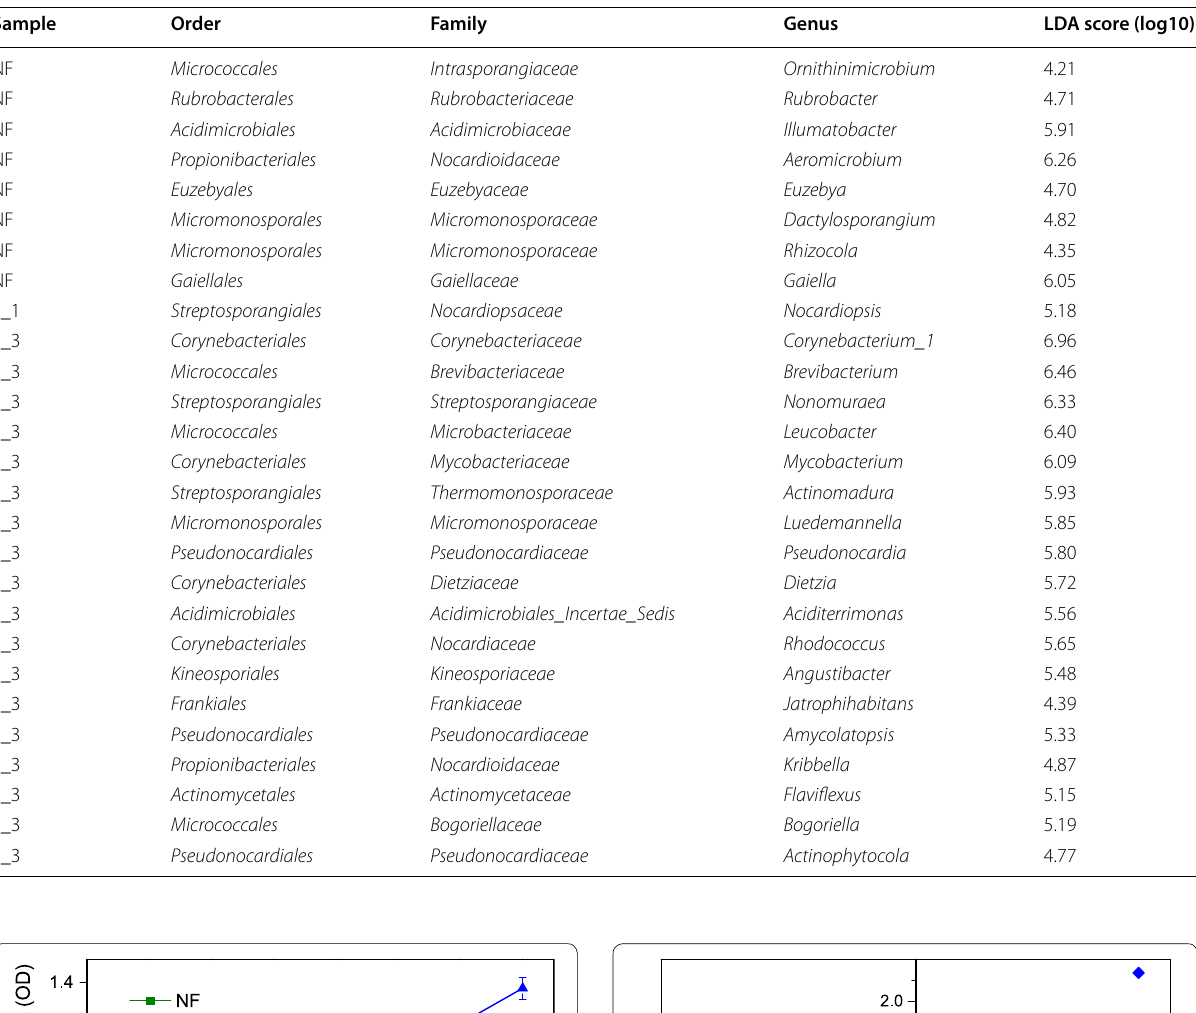
Table 1 The screen out genera by LEfSe belong to phylum Actinobacteria